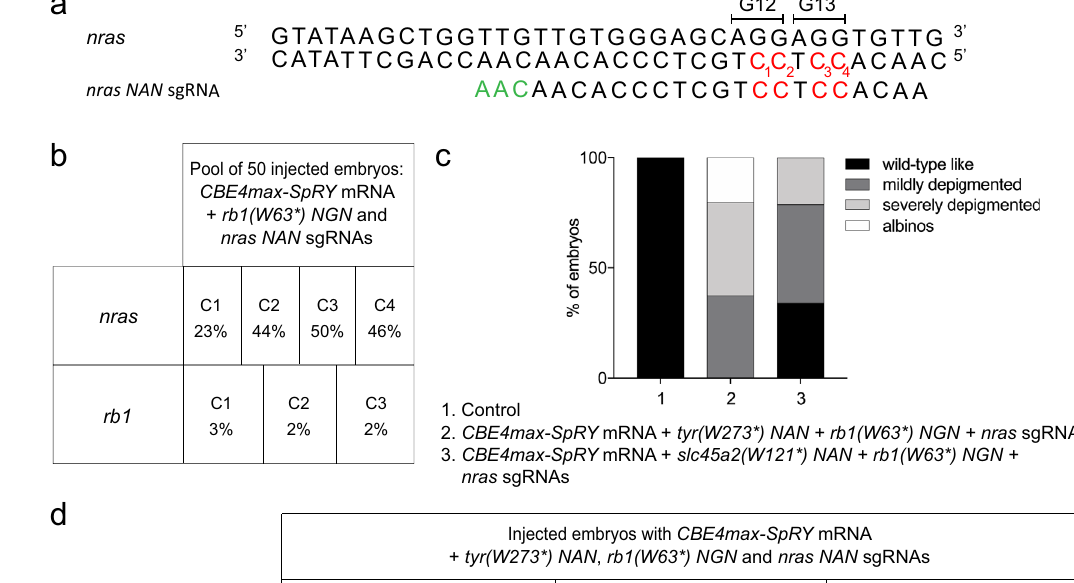
embryosPool of 60 mildly depigmented embryos